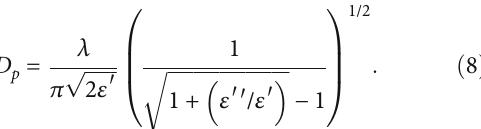
is the power absorbed by the abs